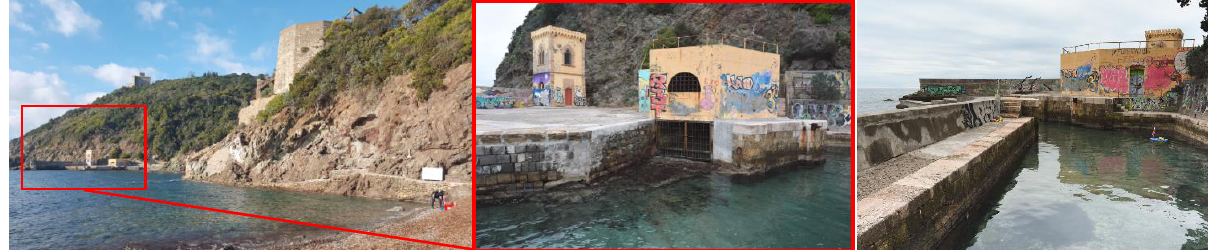
Figure 3. The surveyed port structure in the bay of Rogiolo near Livorno,